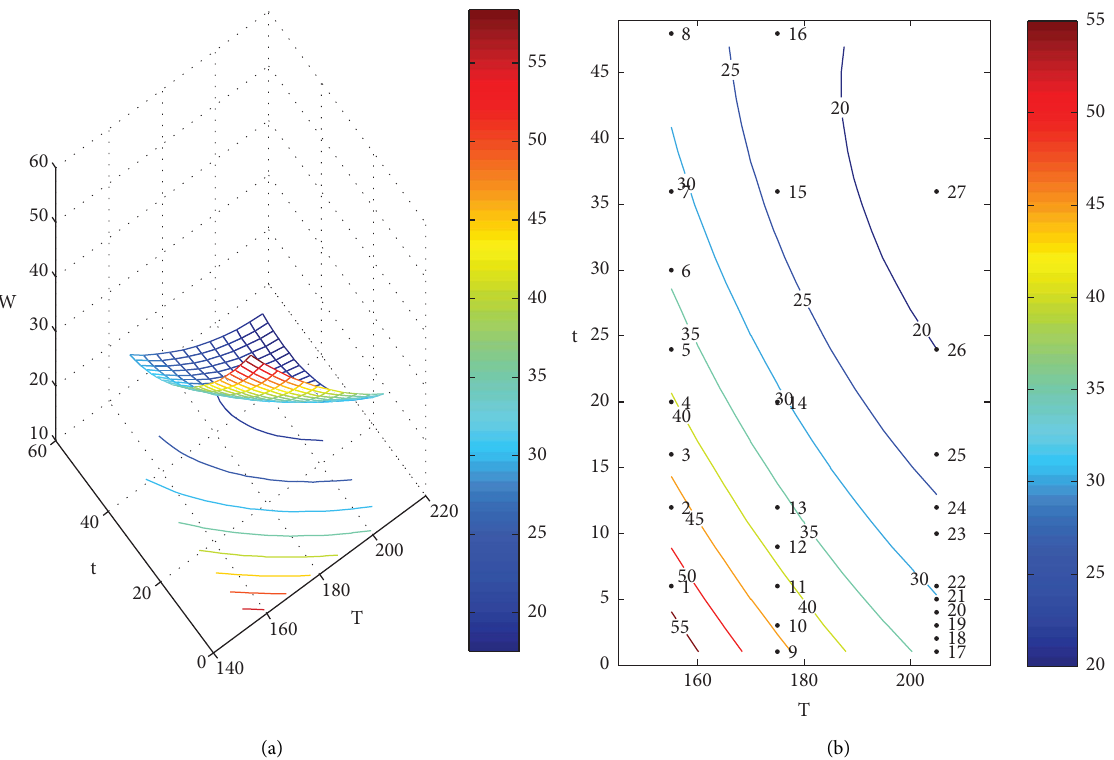
Figure 4: 3D surface graph of the regression model (a) and quality map (b) for W of cast aluminum alloy A357 according to artifcial aging heat treatment